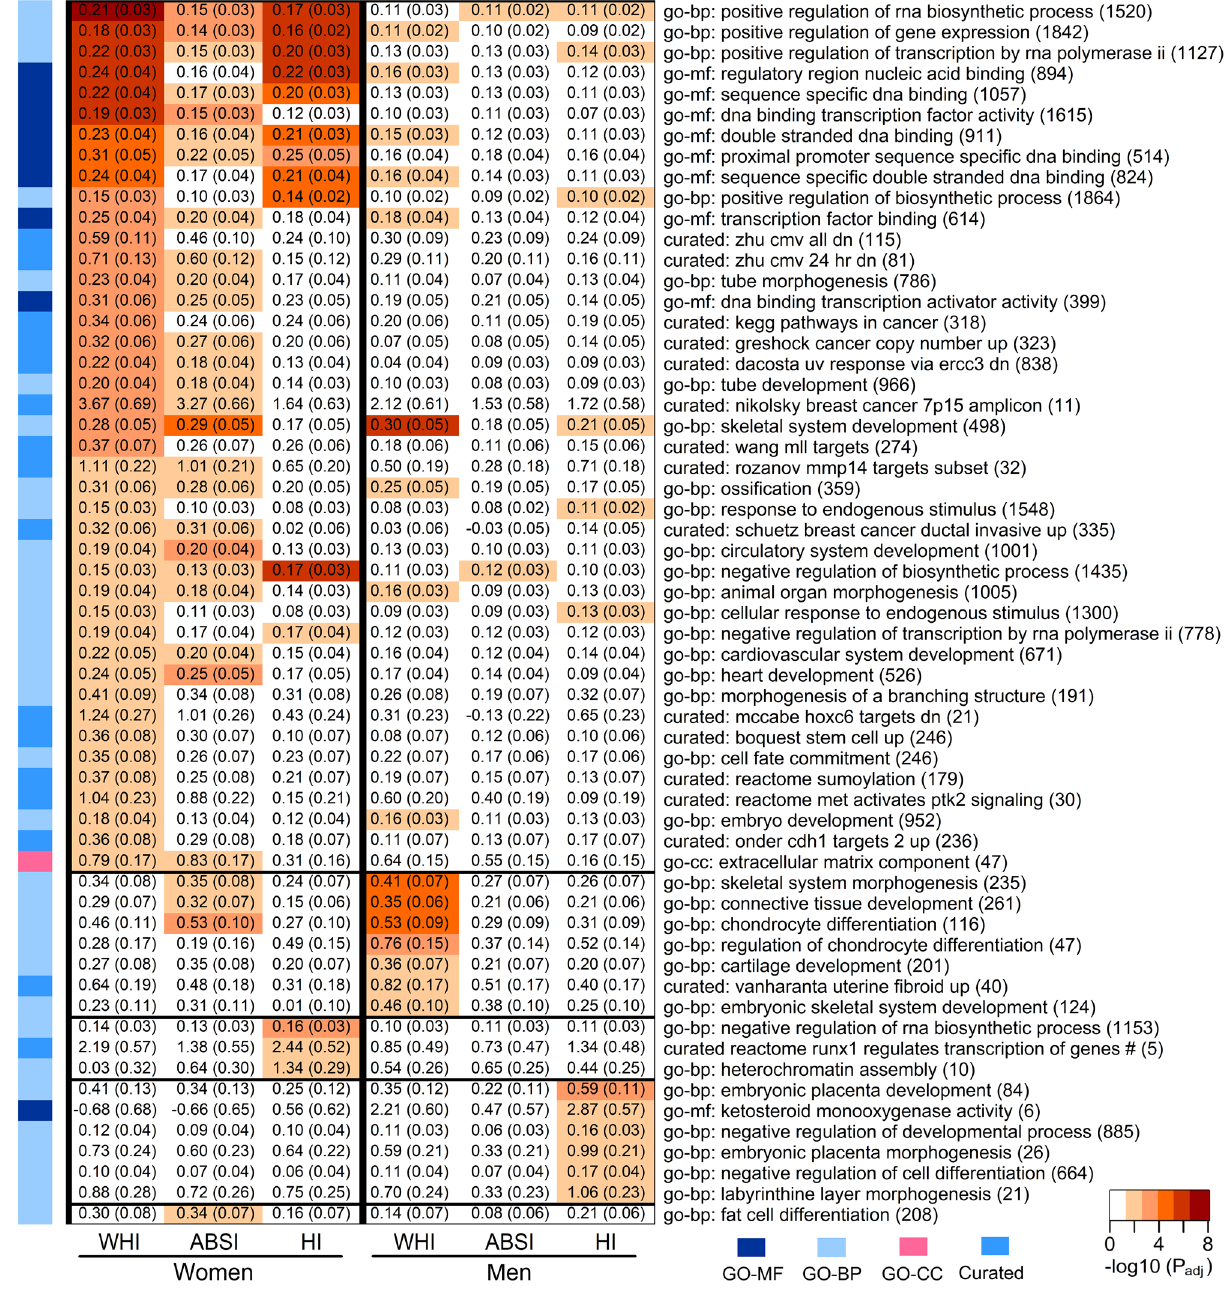
Figure 4. Gene sets associated with allometric body-shape indices. ABSI-a body shape index calibrated for UK Biobank participants (ABSI UKB ); Currated-curated gene set; GO-BP-gene ontology biological process; GO-CC- gene ontology cellular component; GO-MM-gene ontology molecular function; HI-hip index calibrated for UK Biobank participants (HI UKB ); WHI-waist-to-hip index calibrated for UK Biobank participants (WHI UKB ); #-reactome runx1 regulates transcription of genes involved in wnt signaling. The figure includes gene sets identified using competitive gene-set analysis with MAGMA v1.08 employed in FUMA v1.3.6a as significant for at least one of the allometric indices in women or men with adjusted P adj < 0.05, incorporating Bonferroni correction for multiple comparisons for 15,485 gene sets. Gene sets with P adj < 0.05 for WHI UKB in women were sorted in descending order of P adj , for WHI UKB in women, then the remaining gene sets with P adj < 0.05 for WHI UKB in men were sorted in descending order of P adj for WHI UKB in men, then the remaining gene sets with P adj < 0.05 for HI UKB in women were sorted in descending order of P adj for HI UKB in women and last, the remaining gene sets with P adj < 0.05 for HI UKB in men were sorted in descending order of P adj for HI UKB in men, leaving a single gene set associated only with ABSI UKB in women. The horizontal lines mark the start of the next sorting criterion. White cells are gene sets with P adj ≥ 0.05 for the corresponding body-shape